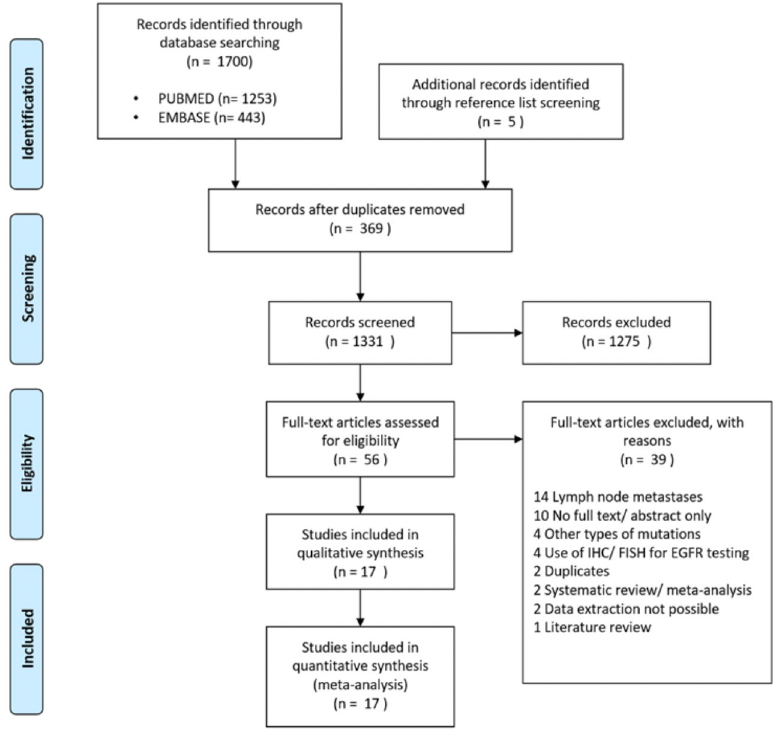
Fig 1. Flow diagram of study selection. Abbreviation: IHC = immunohistochemistry; FISH = fluorescence in-situ hybridization; EGFR = epidermal growth factor receptor.